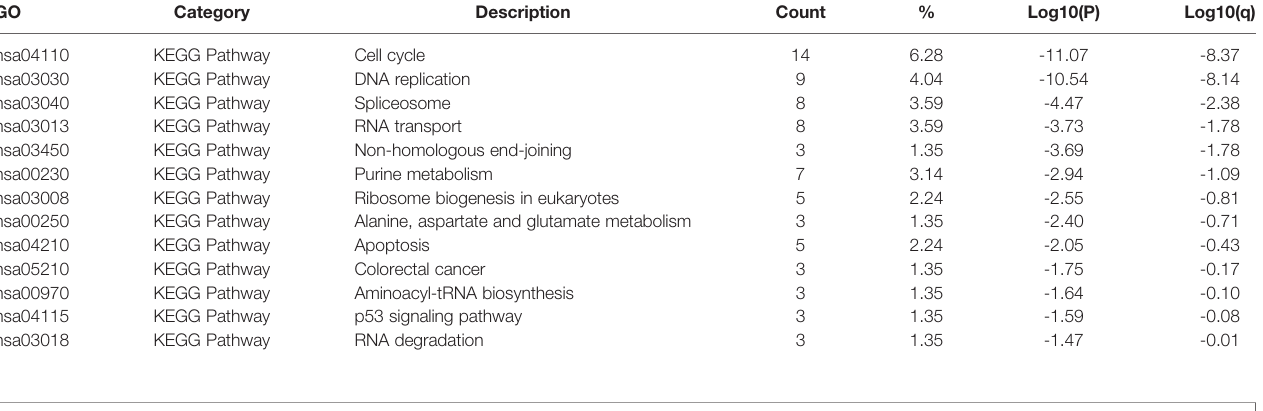
TABLE 4 | KEGG enrichment analyses of E2Fs and their similar genes in STAD (Metascape). GO Category